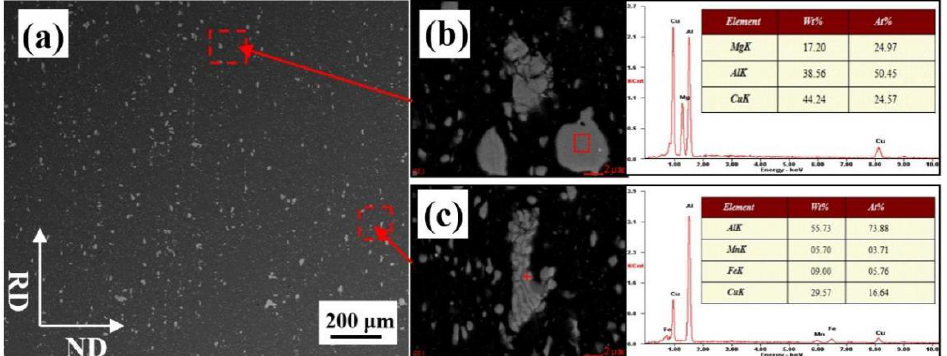
Figure 5. BSE images and EDS results of the as-hot-rolled sample: ( a ) macroscopic BSE image showing the CSPs arranged along RD; ( b ) BSE image and EDS result indicating ellipsoidal-shaped S(Al 2 CuMg) phase; ( c ) BSE image and EDS result indicating the presence of an irregularly shaped AlCuFeMn phase.